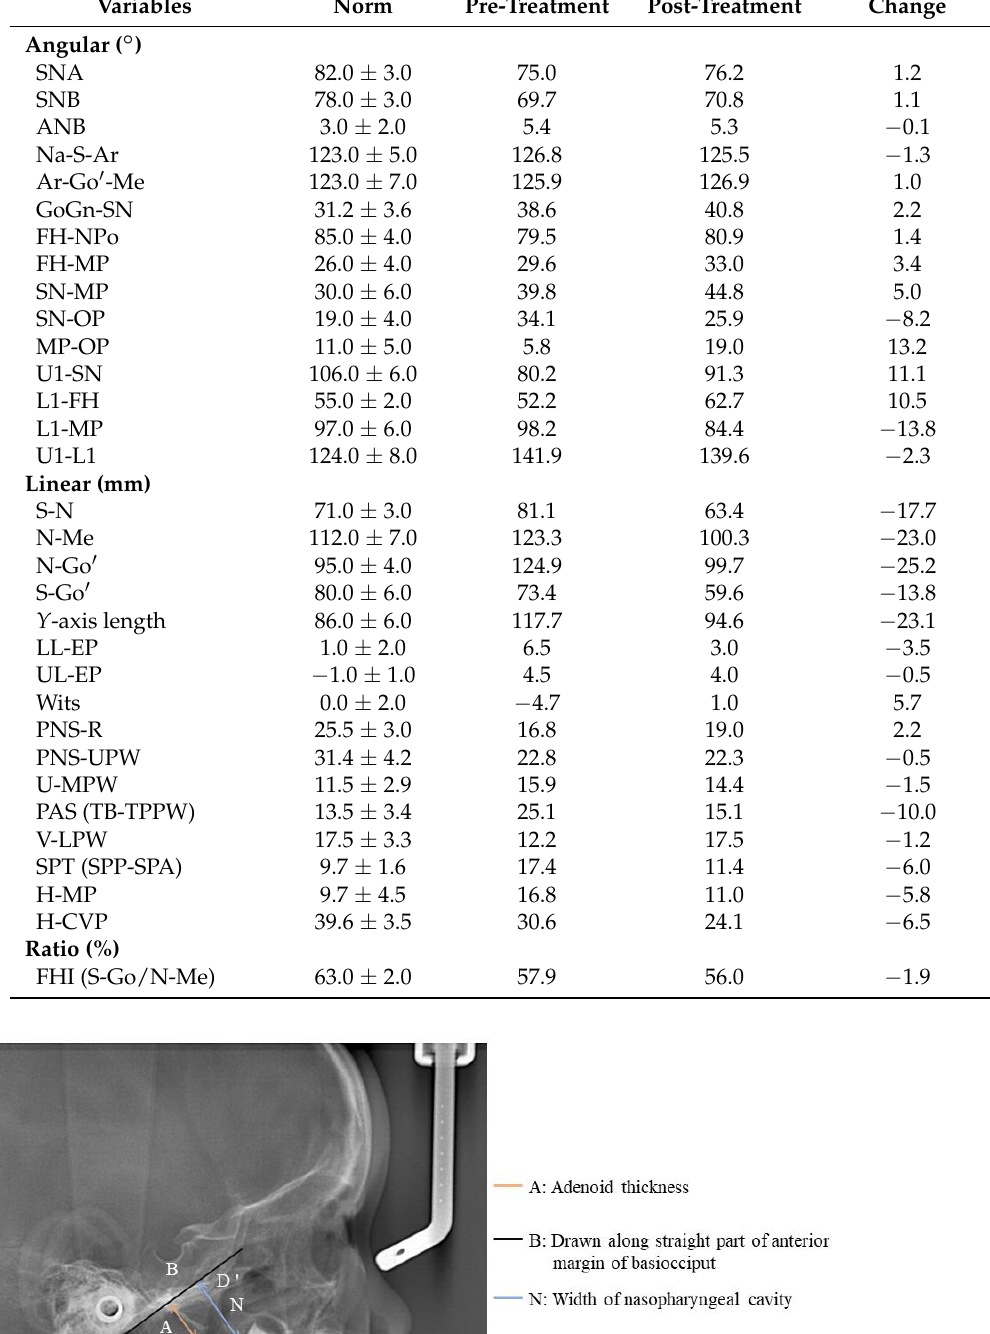
Table 1. Cephalometric analysis.